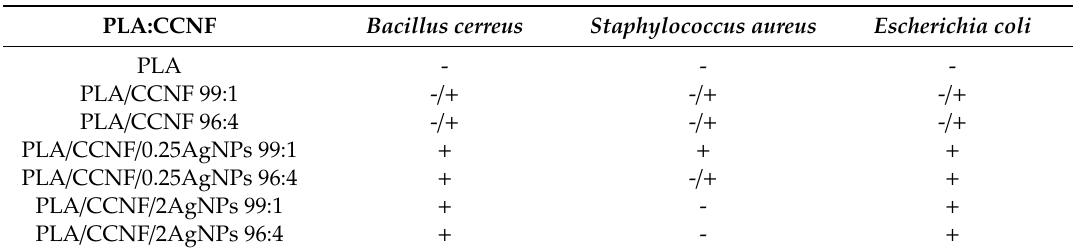
Table 4. Antimicrobial activity of films obtained for neat PLA and PLA reinforced with CCNF, CCNF / 0.25AgNPs, and CCNF / 2AgNPs. PLA:CCNF Bacillus cerreus Staphylococcus aureus Escherichia